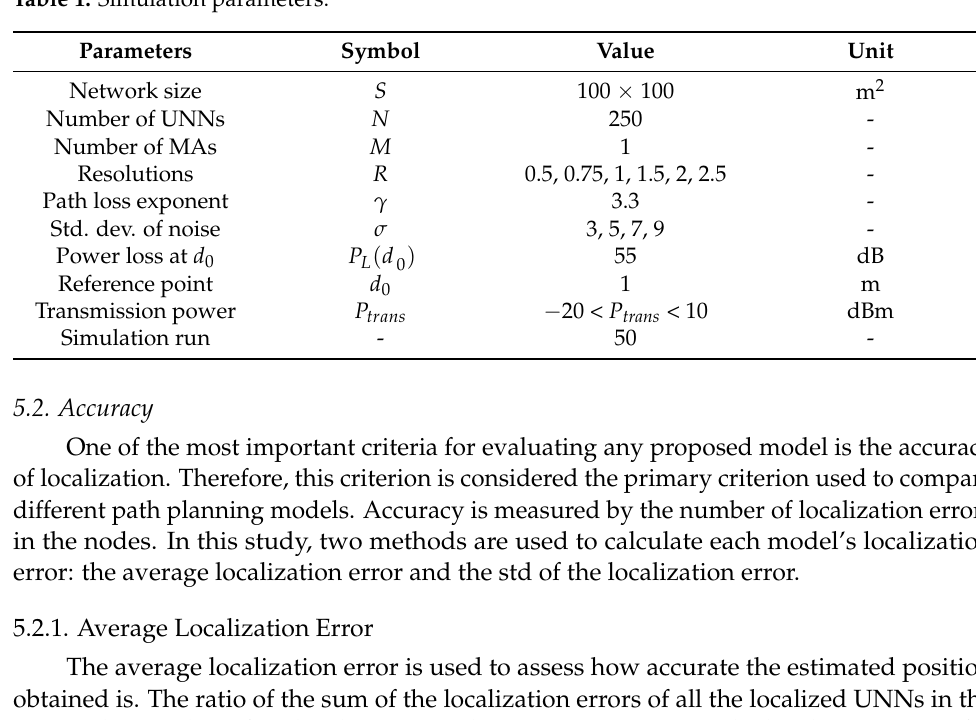
Table 1. Simulation